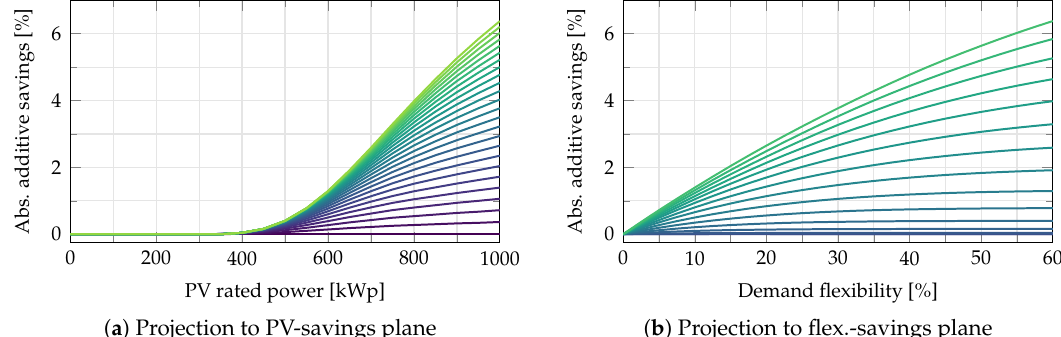
Figure 9. Two-dimensional projections of the additional achievable savings to the PV rated power-savings plane ( a ) and flexibility-savings plane ( b ). The color shift from blue to green corresponds to the increase of flexibility on the left graph and the increase in PV rated power on the right